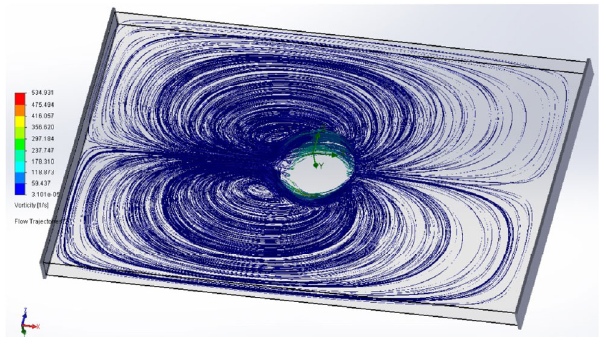
Fig. 4 Vorticity distribution for v =0.08333 m/s in Tonna V68.